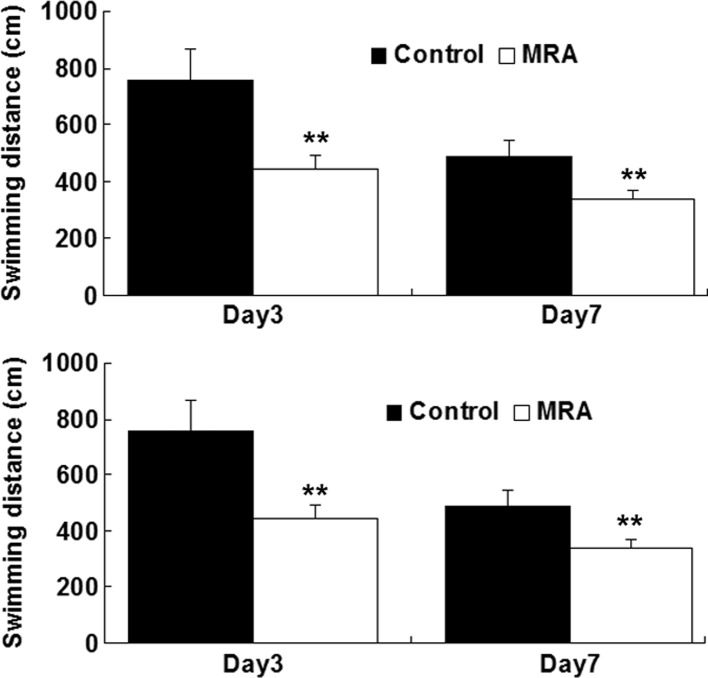
Swimming distance and time of aged rats in the Morris water maze assay. Results presented are the mean ± standard deviation. Day3, the Morris water maze test was performed on the third day after surgery; Day7, the Morris water maze assay was performed on the seventh day after surgery; control, rats received surgery without MRA (tocilizumab); MRA, rats received surgery with MRA. **P<0.01 vs. control.